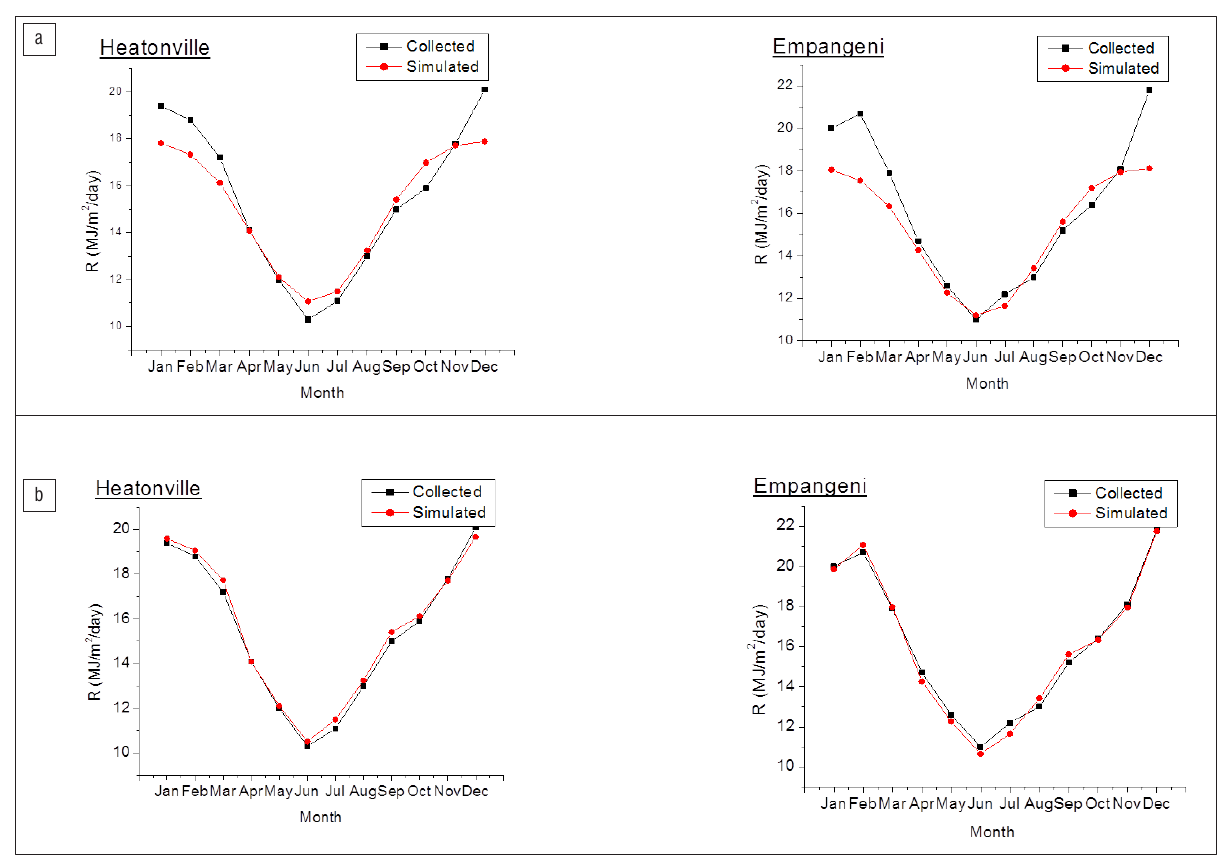
Figure 2: Simulated and collected data (a) before and (b) after inclusion of the diffusion factor for Heatonville and Empangeni.